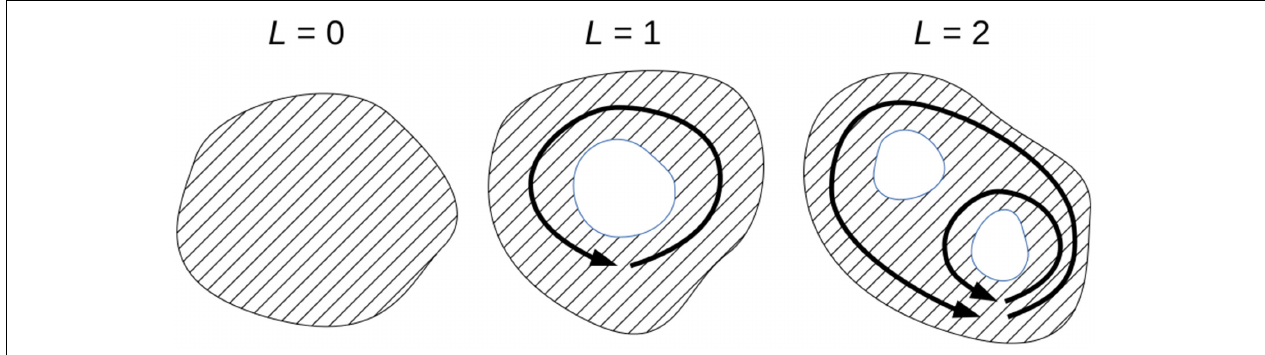
FIGURE 3 | Simply connected region (left, genus L = 0) and multiply connected regions with the genus L = 1 (middle) and L = 2 (right).